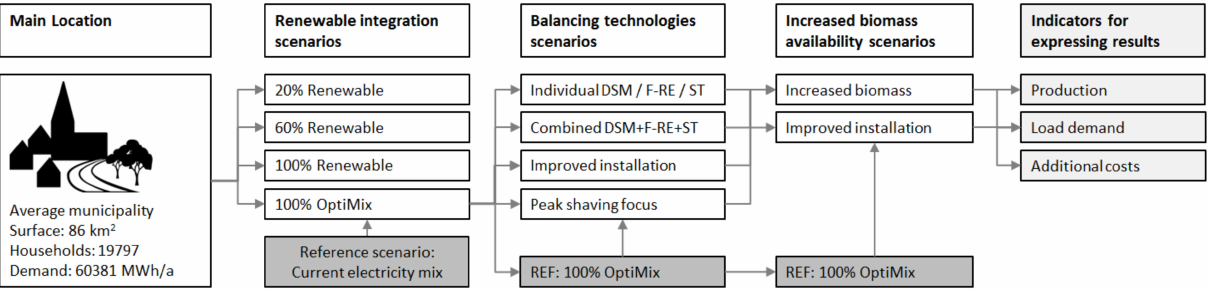
Figure A4. Scenarios used within this article.